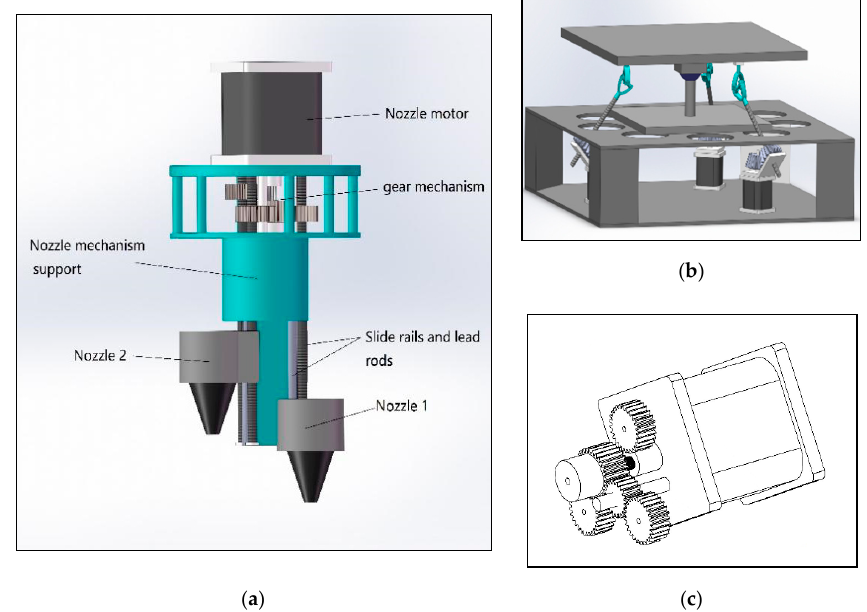
Figure 5. Printer nozzle mechanism. ( a ) Nozzle body; ( b ) Nozzle structure gear layout; ( c ) Printer platform mechanism.